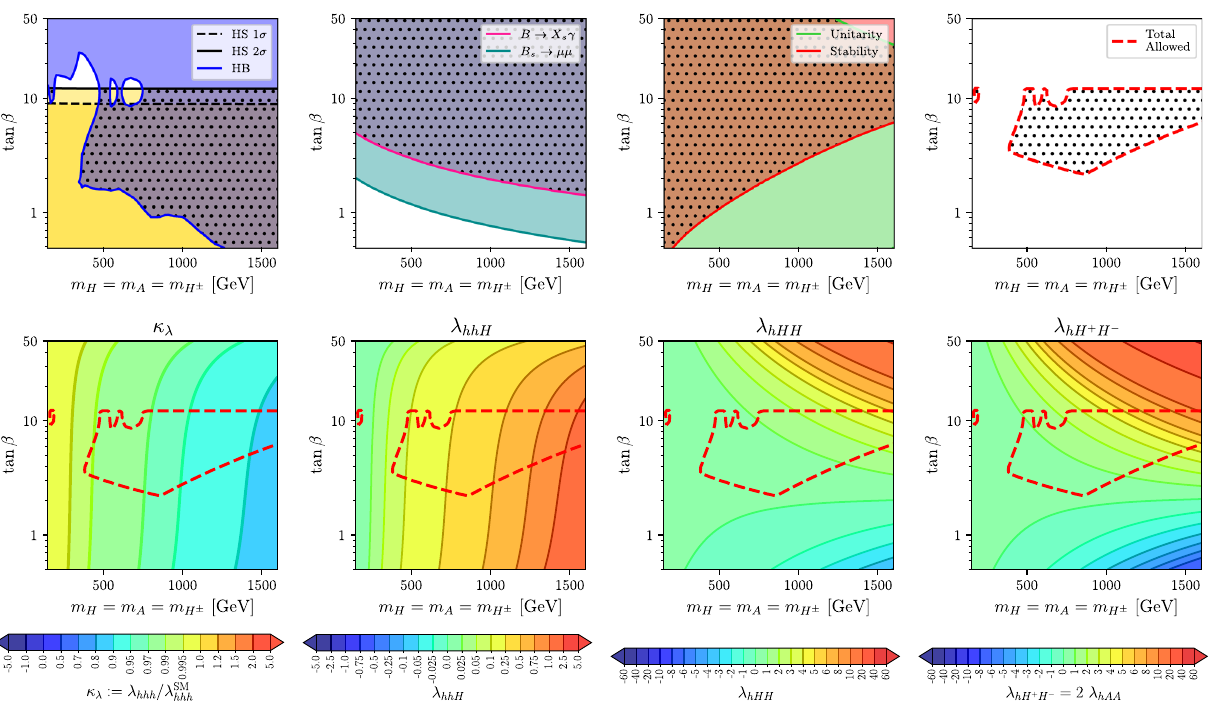
Fig. 14 Allowed areas (dotted regions) from the various constraints (upper row) and triple Higgs couplings (lower row) for the benchmark scenario IV-3 in the m ≡ m H = m A = m H ± –tan β plane with c β − α = 0 . 02 and m 2